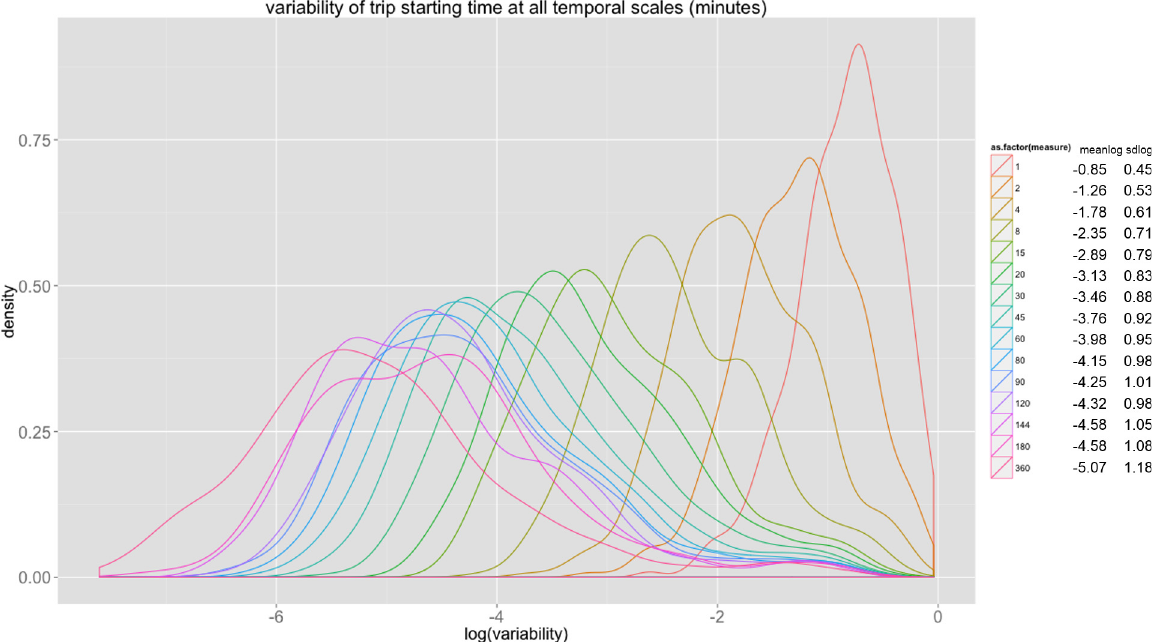
Fig 3. Distribution of the variability of trip starting time at London underground stations. Note: Less variance as the temporal scale gets finer while log normality is consistent over all scales.